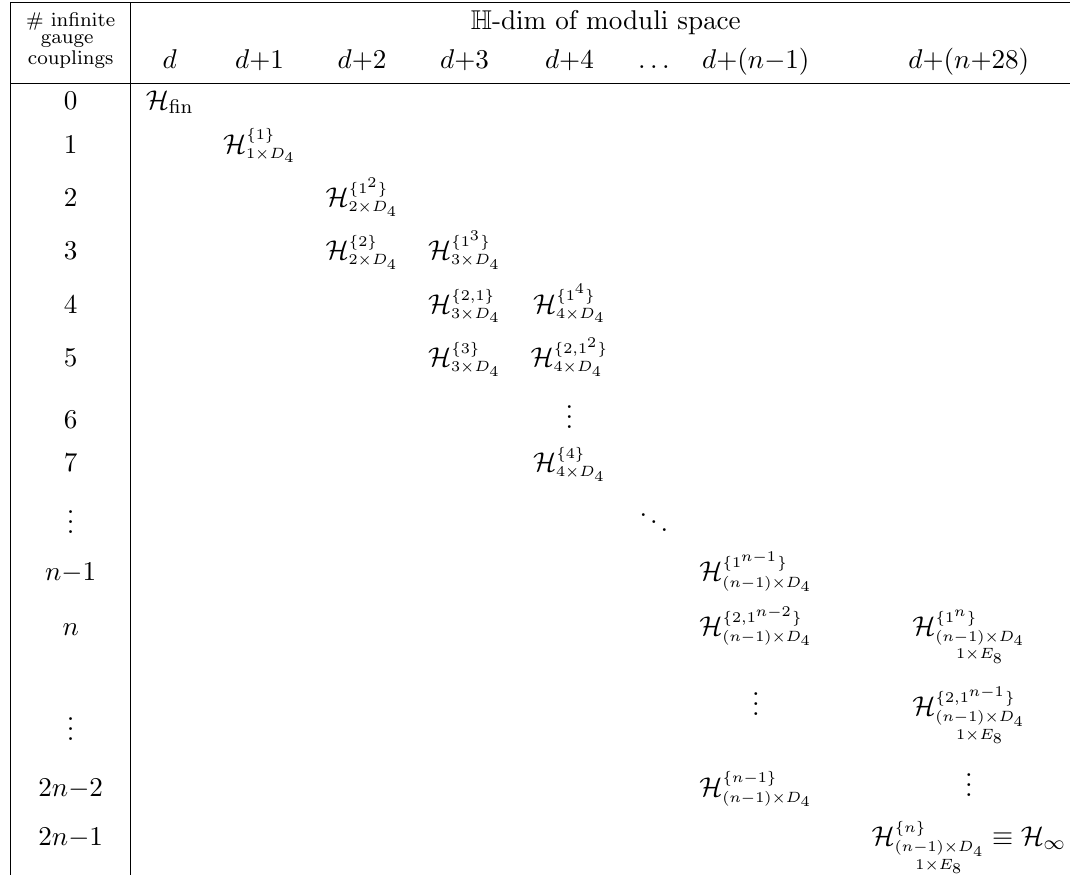
Table 5 . The multitude of Higgs branch phases for n M5s on a C 2 = D k (cid:0) 2 singularity. The subscript p (cid:2) D 4 indicates p D 4 transitions, while 1 (cid:2) E 8 indicate the single small instanton transitions.